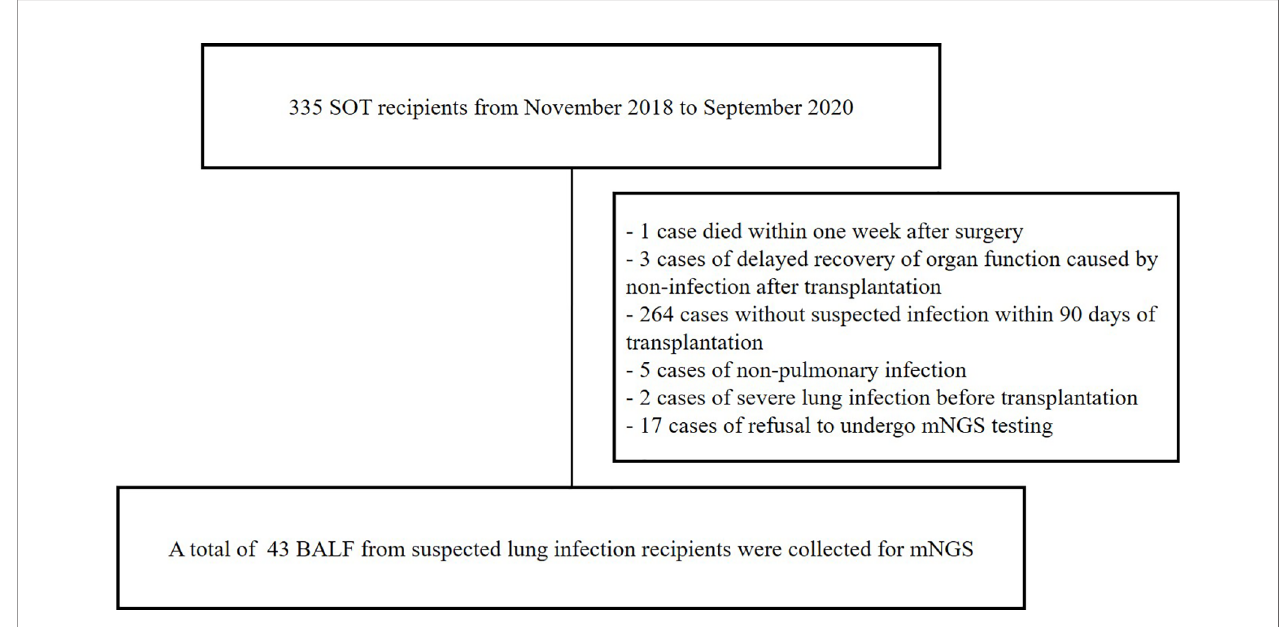
FIGURE 1 | Study design in solid organ